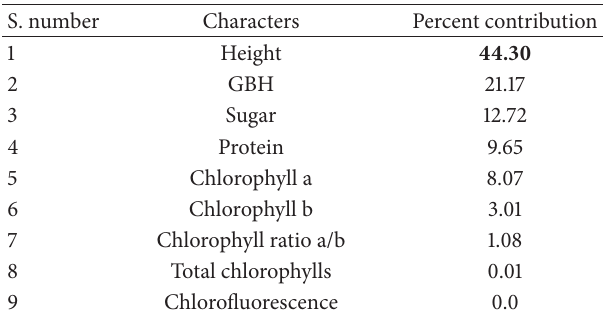
Table 5: Contribution of different leaf morphophysiological and biochemical quantitative characters in creating diversity in Shisham